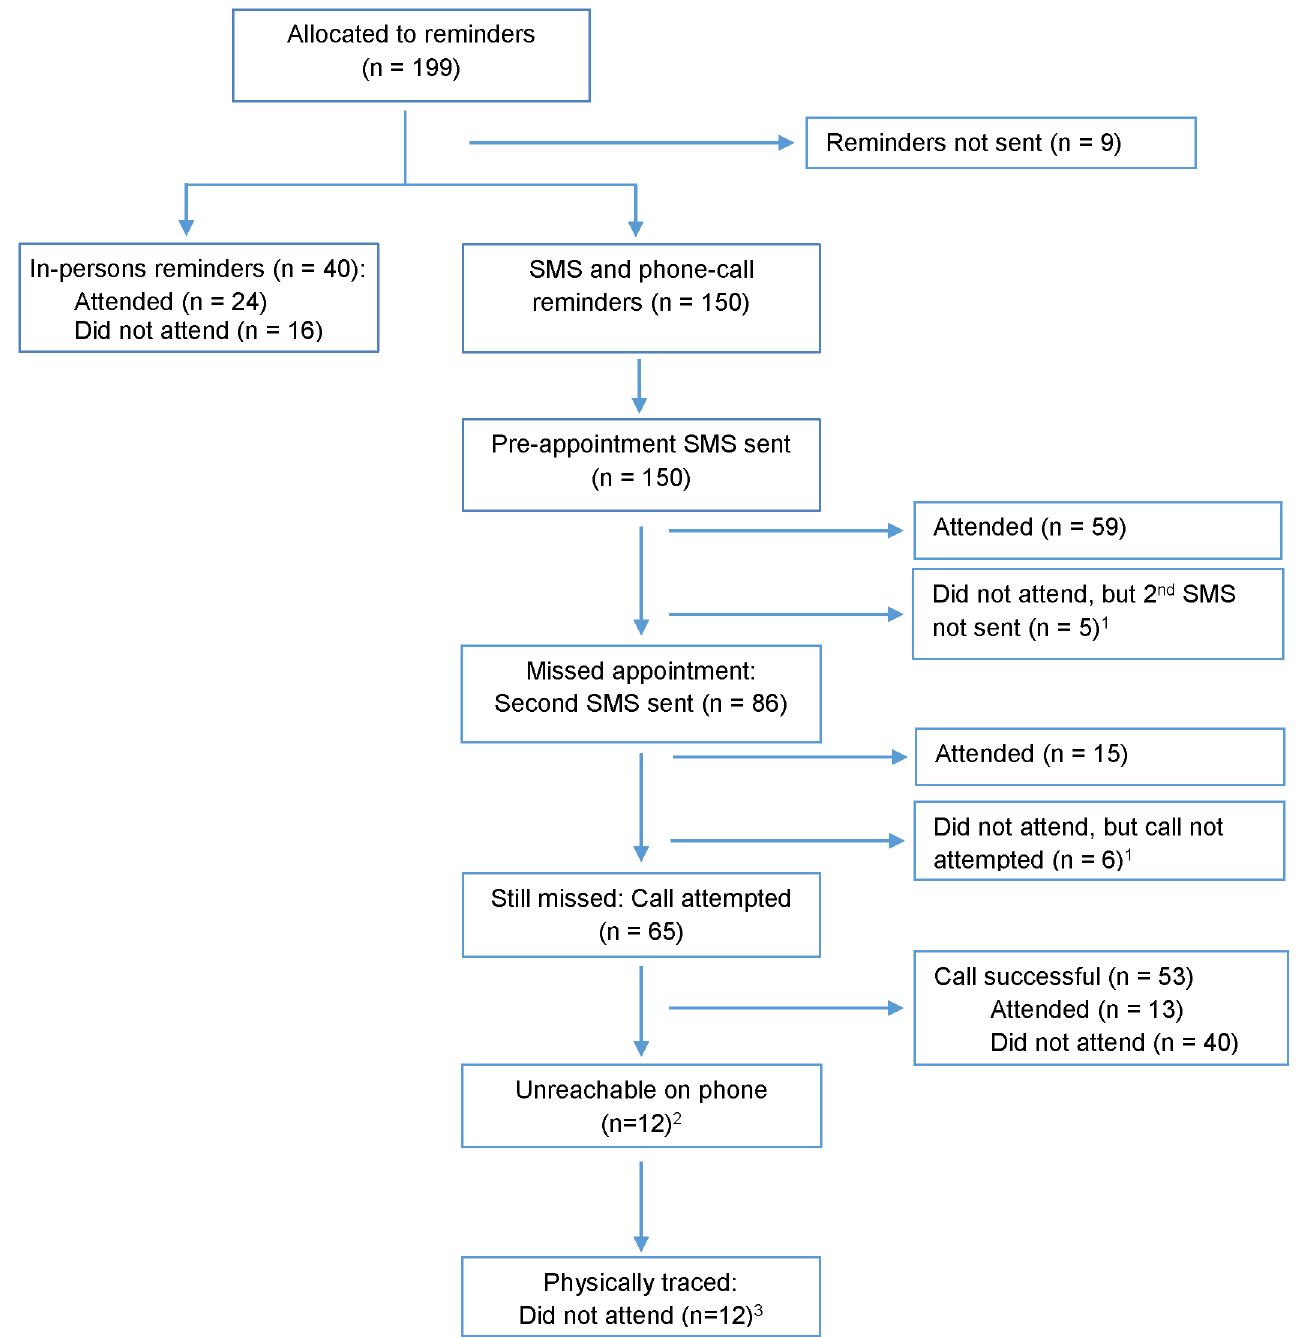
Fig 2. Delivery and outcome of appointment reminders. 1 Due to delays in communication from study sites, follow-up reminders were not sent for five participants after the first SMS and for six participants after the second SMS. 2 Twelve participants who had provided a valid mobile at enrolment were subsequently unreachable at the follow-up visit, perhaps due to lost mobile phone or changed numbers. 3 Three participants could not be found at the address they had given on the locator form, but we could not determine if they had given incorrect information or had moved.